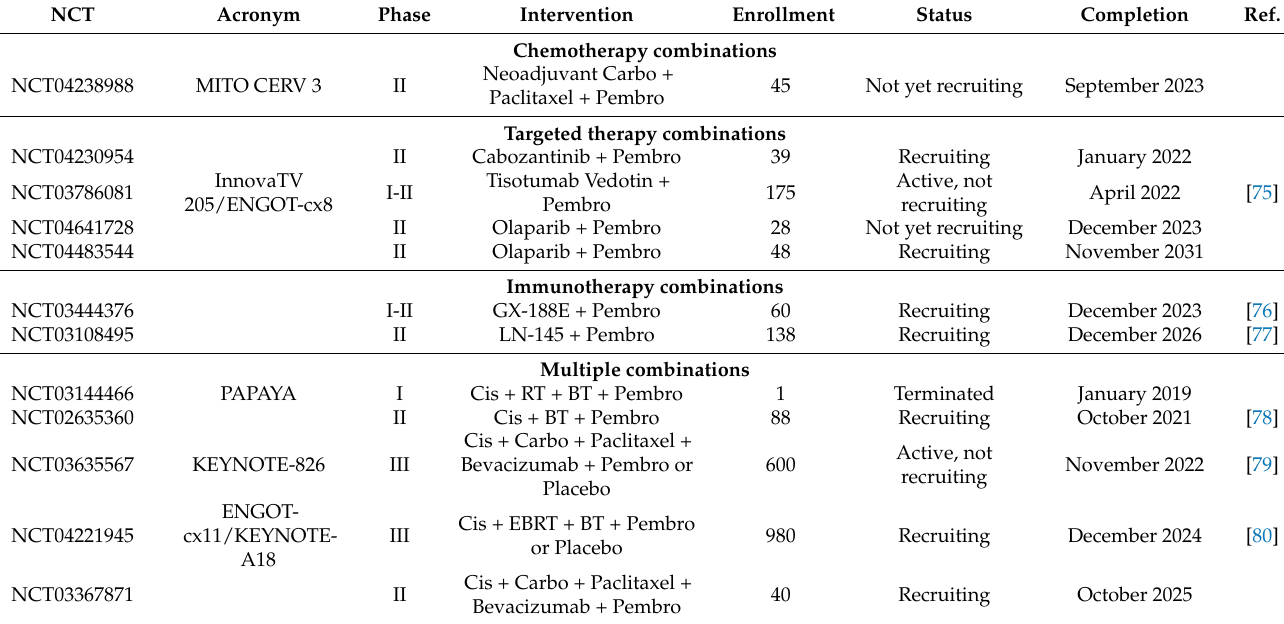
Table 2. Current recruiting and non-recruiting clinical trials assessing pembrolizumab solely in patients with cervical cancer.